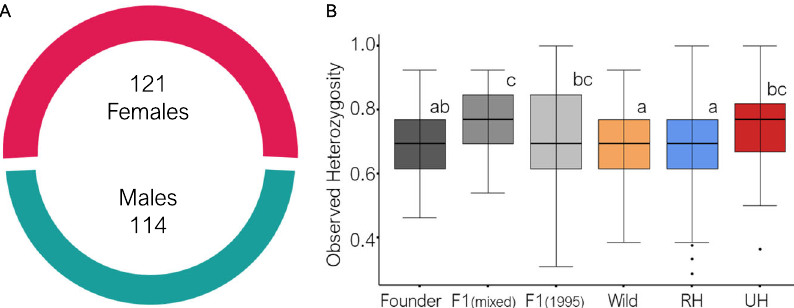
Fig. 5 Analyses of biological parameters. A Genetically estimated breeding population size of the Cayman Islands wild populations during the sampled period showing a sex ratio not signi fi cantly different from 1:1. Females include both wild individuals and females inferred by parentage analysis, while males were all inferred by parentage analysis. B Boxplots of observed heterozygosity values for the CTF breeding stock subgroups, wild females and nests related (RH) or unrelated (UH) to the CTF ( n = 634 individuals). Boxplots sharing a lowercase letter showed non-signi fi cant differences according to two-sided Wilcoxon rank-sum tests, while boxplots not sharing any lowercase letter presented signi fi cant differences. The details of each pairwise Wilcoxon rank- sum can be found in the Supplementary Information, Table S5. The lower and upper hinges of each boxplot correspond to the fi rst and third quartiles (the 25th and 75th percentiles). The upper whisker extends from the hinge to the largest value no further than 1.5 * IQR from the hinge (where IQR is the inter- quartile range). The lower whisker extends from the hinge to the smallest value at most 1.5 * IQR of the hinge. Data beyond the end of the whiskers are called ‘ outlying ’ points and are plotted individually. The line represents the median of all